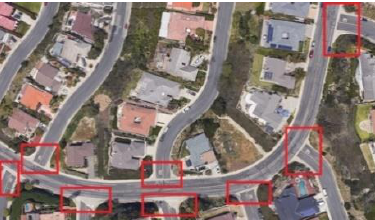
Figure 3. Different colors of road surface in junctions may lead to discontinuities in the extracted roads network.